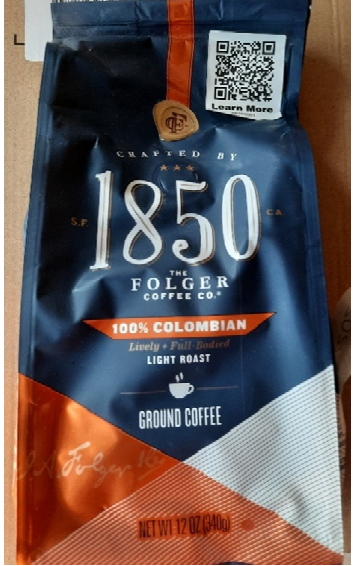
Figure 2. The product delivered to the United Kingdom.